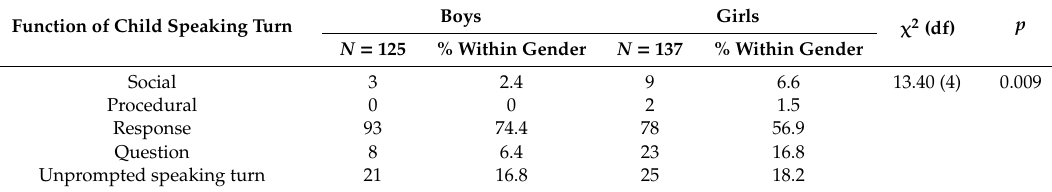
Table 3. Chi-square test of independence of gender and function of child speaking